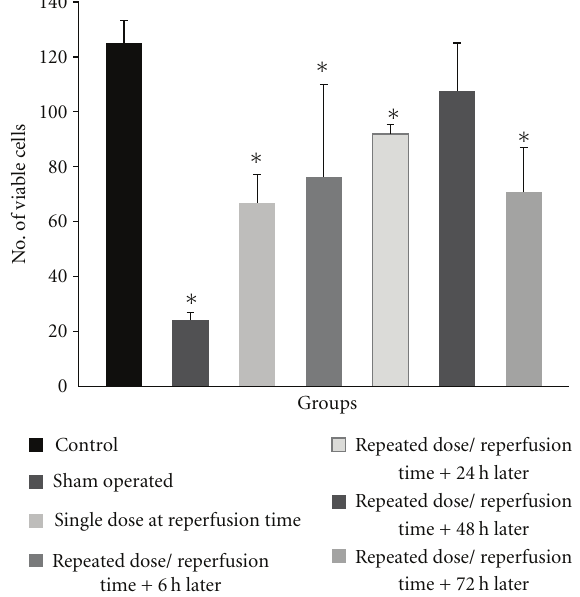
Figure 2: The relationship of repeated injections of FK506 on ischemia reperfusion in various time on pyramidal cell number of CA1. ∗ P < 0 . 05 versus control and repeated dose/reperfusion time, 48h later